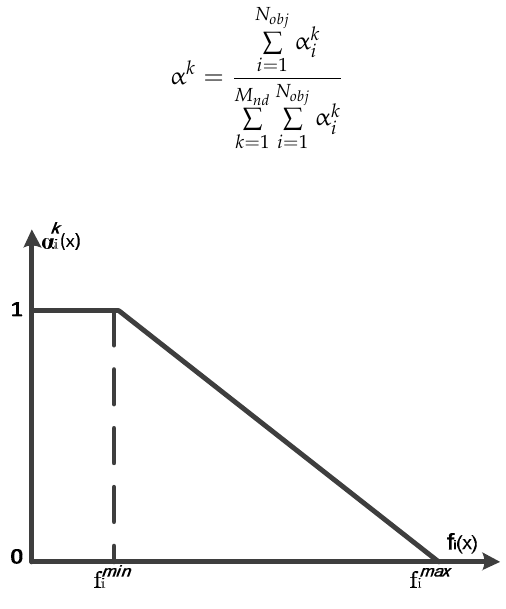
Figure 4. Linear fuzzy-decision model.